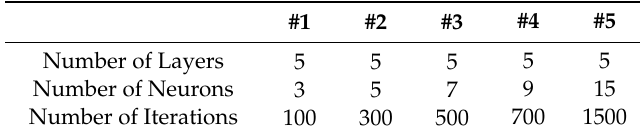
Table 4. The combinations of parameters for the artificial neural network.